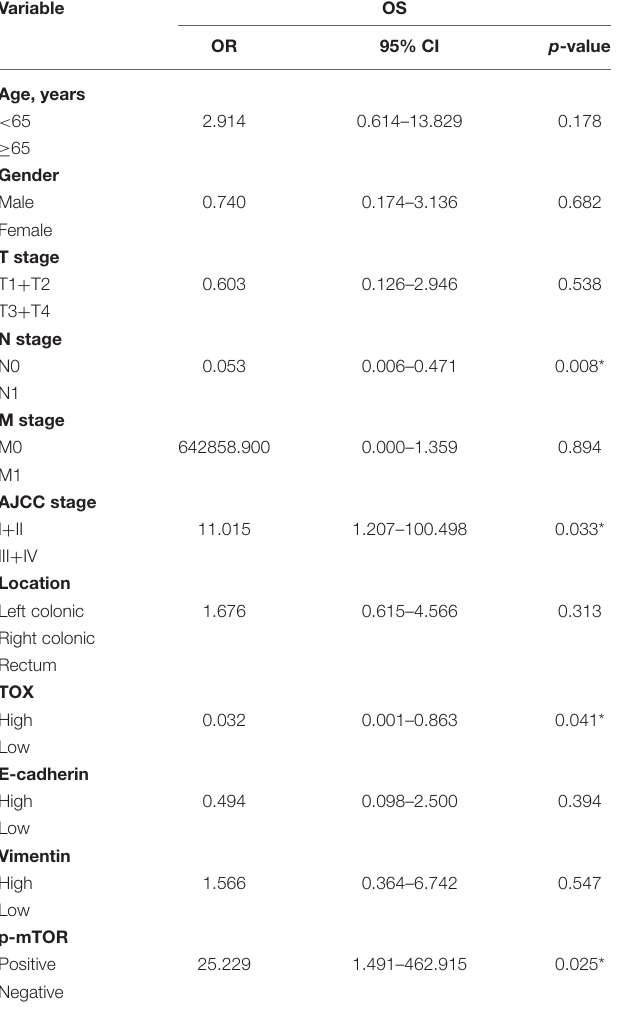
TABLE 3 | Univariate analysis for overall survival (OS).